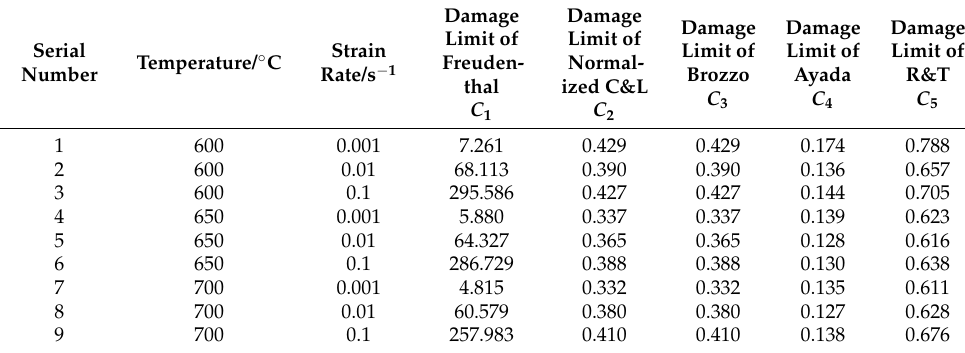
Table 8. Values of damage limit obtained by the tensile